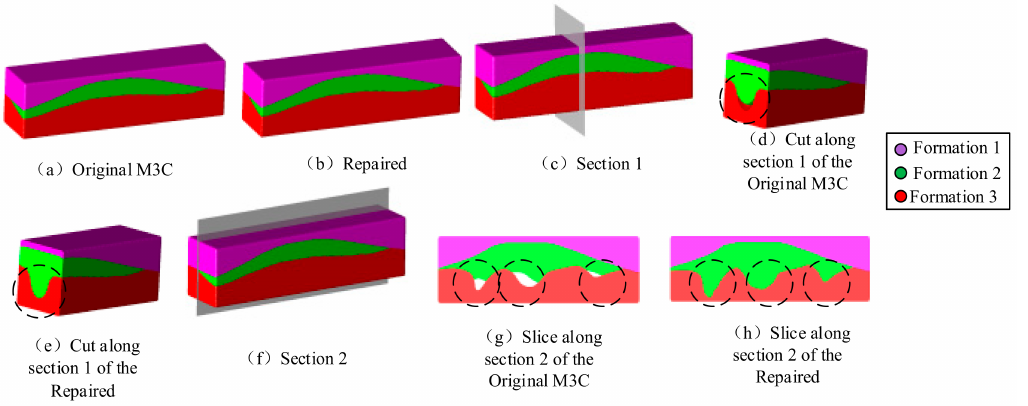
Figure 12. Three-formation geological body.